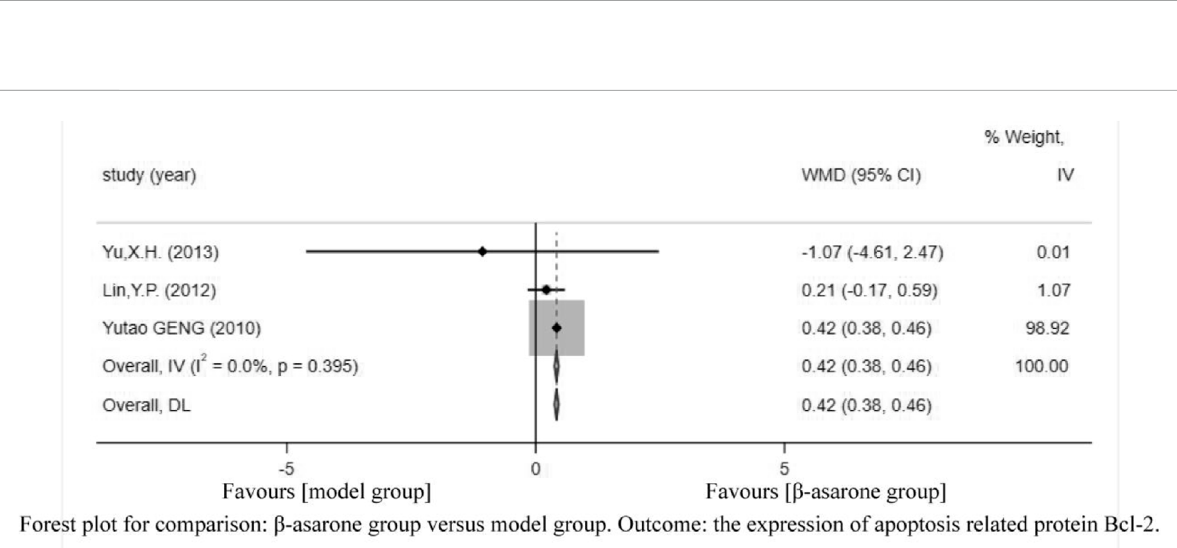
FIGURE 7 Forest plot for comparison: β -asarone group versus model group. Outcome: the expression of apoptosis-related protein